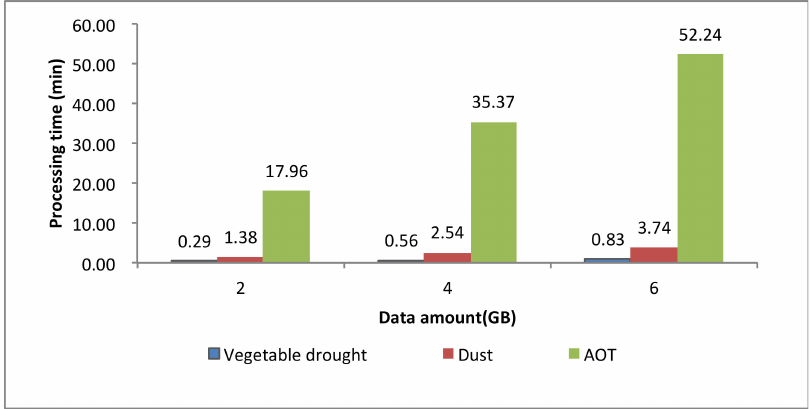
Figure 4. Processing times of various models on Hadoop with 10 nodes as the amount of data increases from 2 to 6